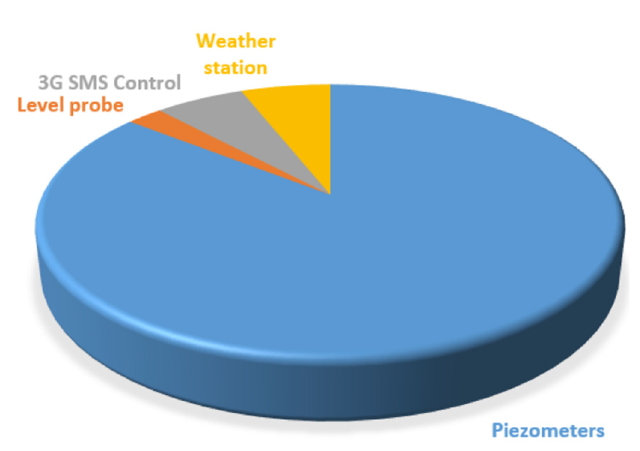
Figure 11. Investments at the beginning of the treatment period.